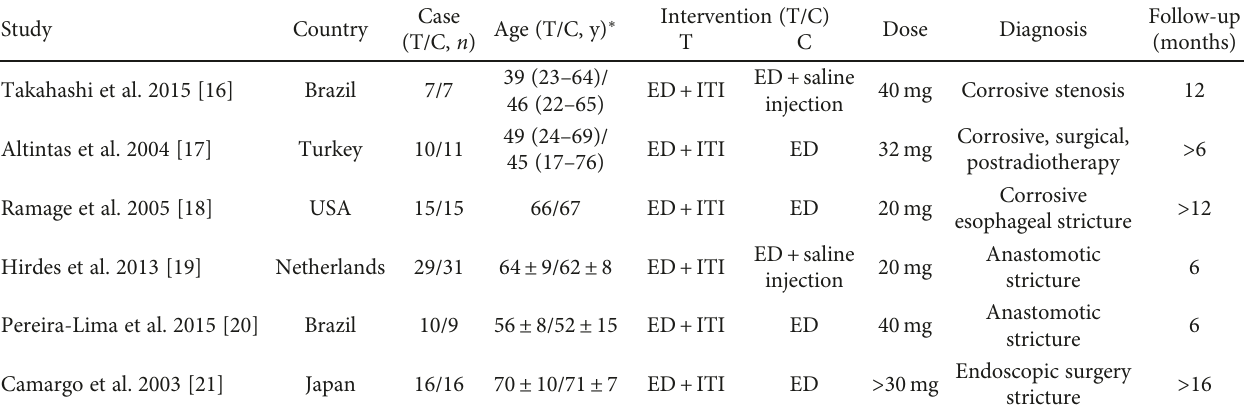
Table 1: Characteristic of included randomized controlled trials.